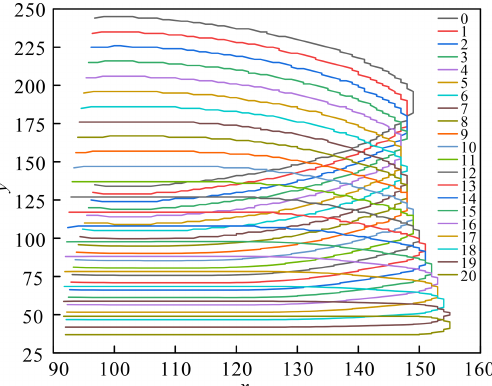
Figure 6. The curve shape of inner wall of oil chamber.